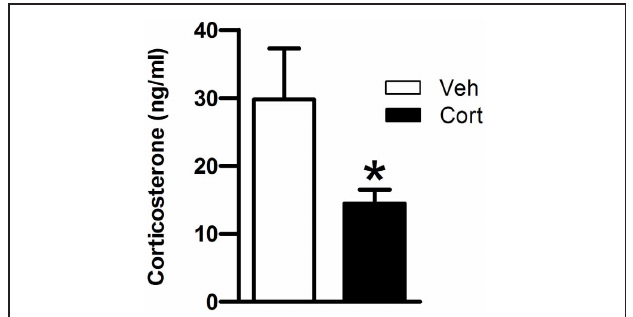
FIGURE 3 | Effect of corticosterone injections during peripuberty on the corticosterone response to a novel environment in adulthood. Blood samples were taken immediately after a 15-min novelty exposure. The results are expressed as mean ± SEM; ∗ p < 0 . 05; N = 11 for Cort group and 9 for Veh group.